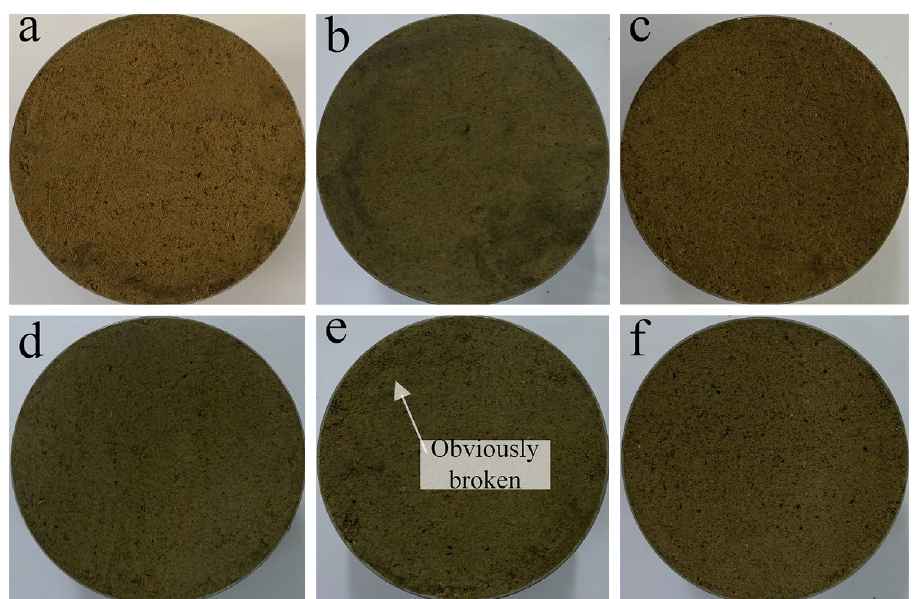
Figure 3. Soil samples with a moisture content of 13%, 1.48 g cm −3 and different freeze–thaw cycles: ( a ) N =